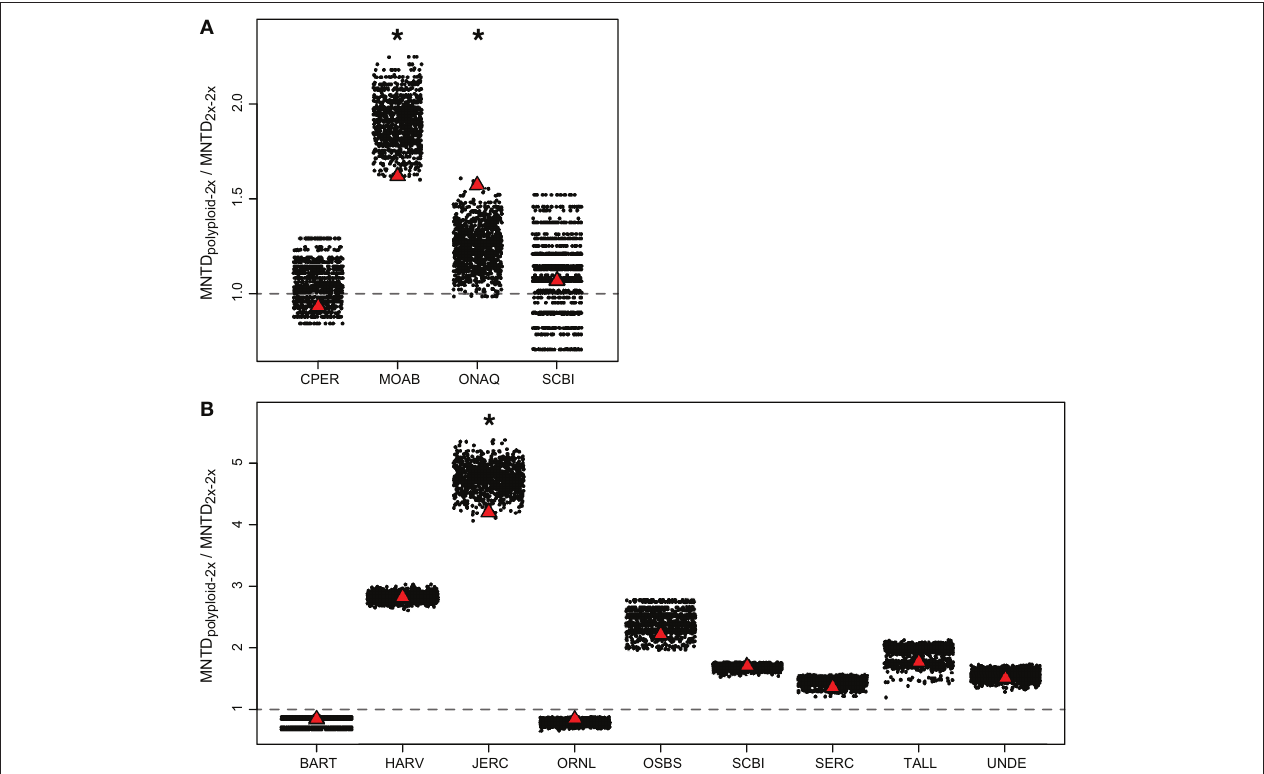
FIGURE 4 | Comparison of observed MNTD polyploid − 2 x / MNTD 2 x − 2 x at each site (red triangle) to simulated random communities (black dots) for (A) Brassicaceae and (B) Rosaceae. The random expectation was generated by randomly replacing polyploid species from a pool of polyploids from all study communities. MNTD polyploid − 2 x / MNTD 2 x − 2 x > 1 (above dashed line) indicates that the mean phylogenetic distance between polyploids and the closest diploid relative in the same community is greater than that between co-occurring diploids. Asterisks indicate that the observed MNTD polyploid − 2 x / MNTD 2 x − 2 x is significantly different